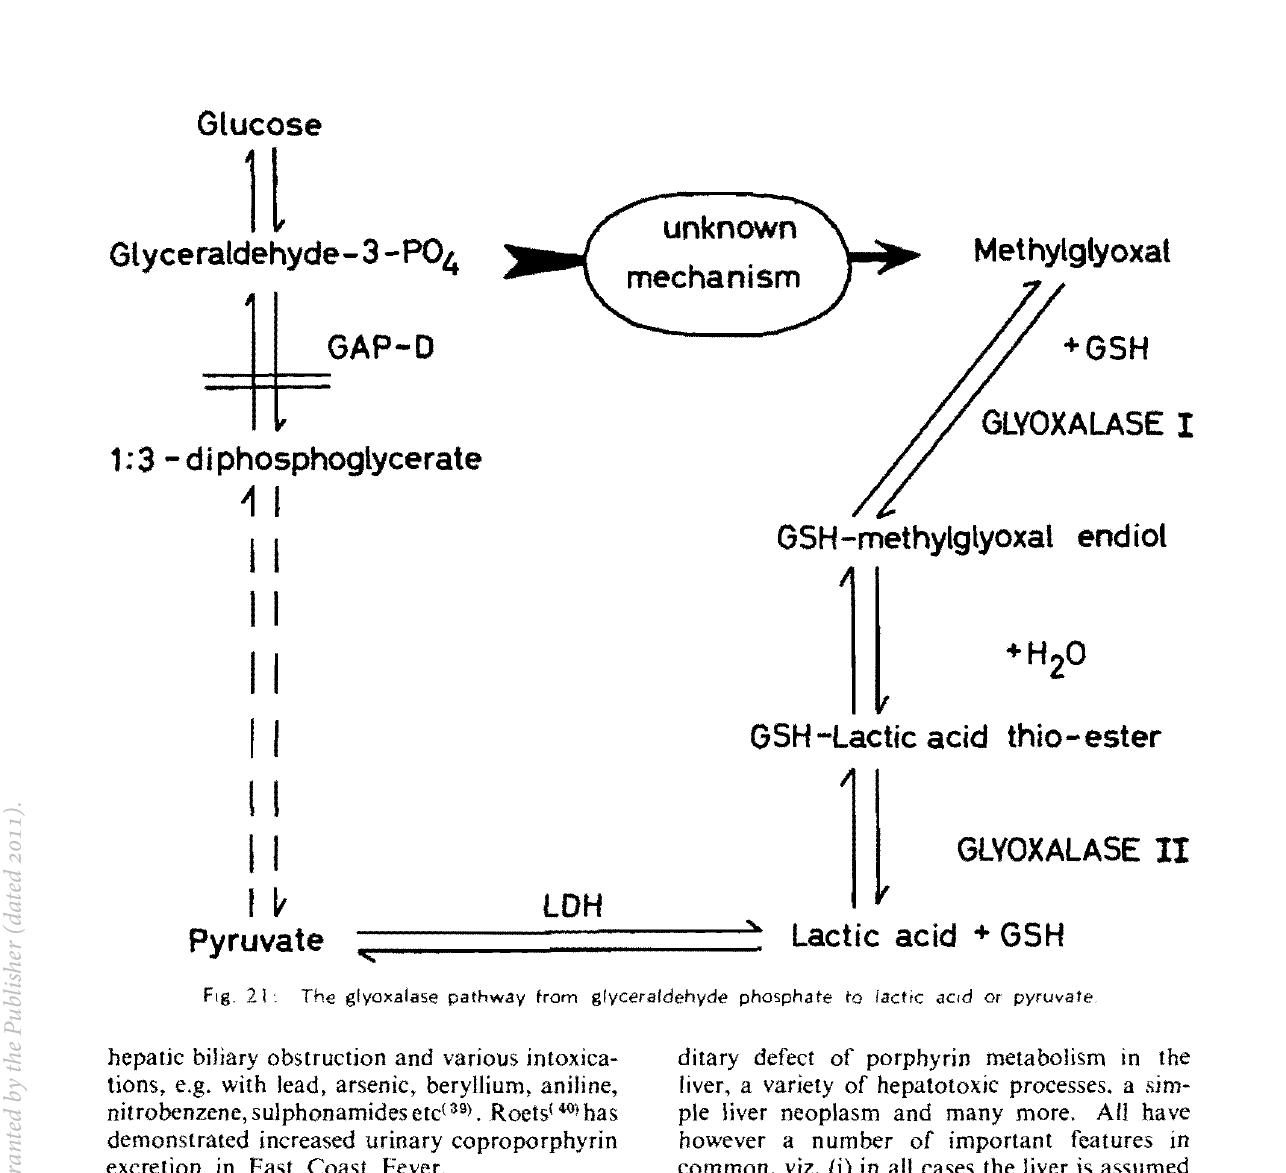
The glyoxalase pathway from glyceraldehyde phosphate to lactic aCId or pyruvate hepatic biliary obstruction and various intoxica tions, e.g. with lead, arsenic, beryllium, aniline, nitrobenzene, sulphonamides etc( 39). Roets' 40) has demonstrated increased urinary coproporphyrin excretion in East Coast